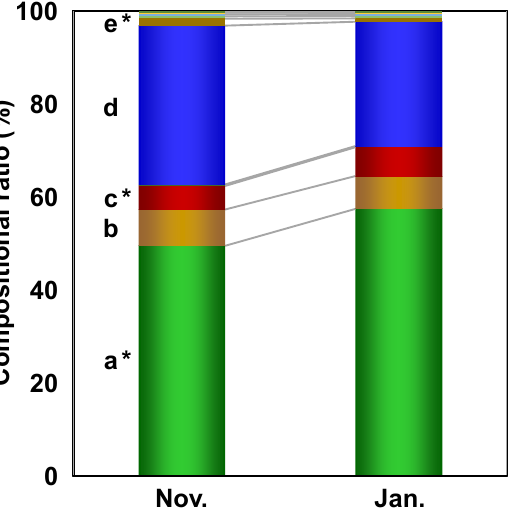
Figure 5. Important metabolites contributing to the harvest period-related SVM classification model.